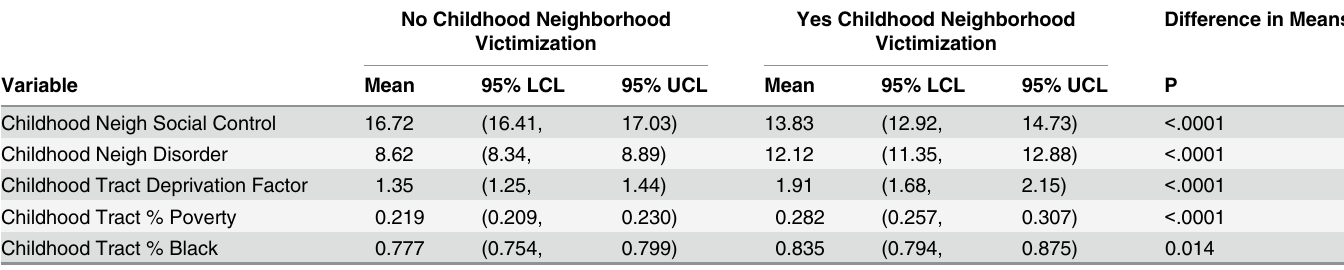
Table 3. T-Tests of Difference in Childhood Neighborhood Context by Childhood Neighborhood Victimization; LIFE